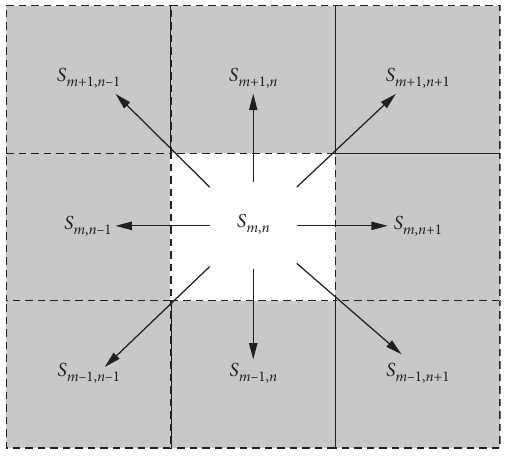
Figure 1: Proposed opening-centric CA model.